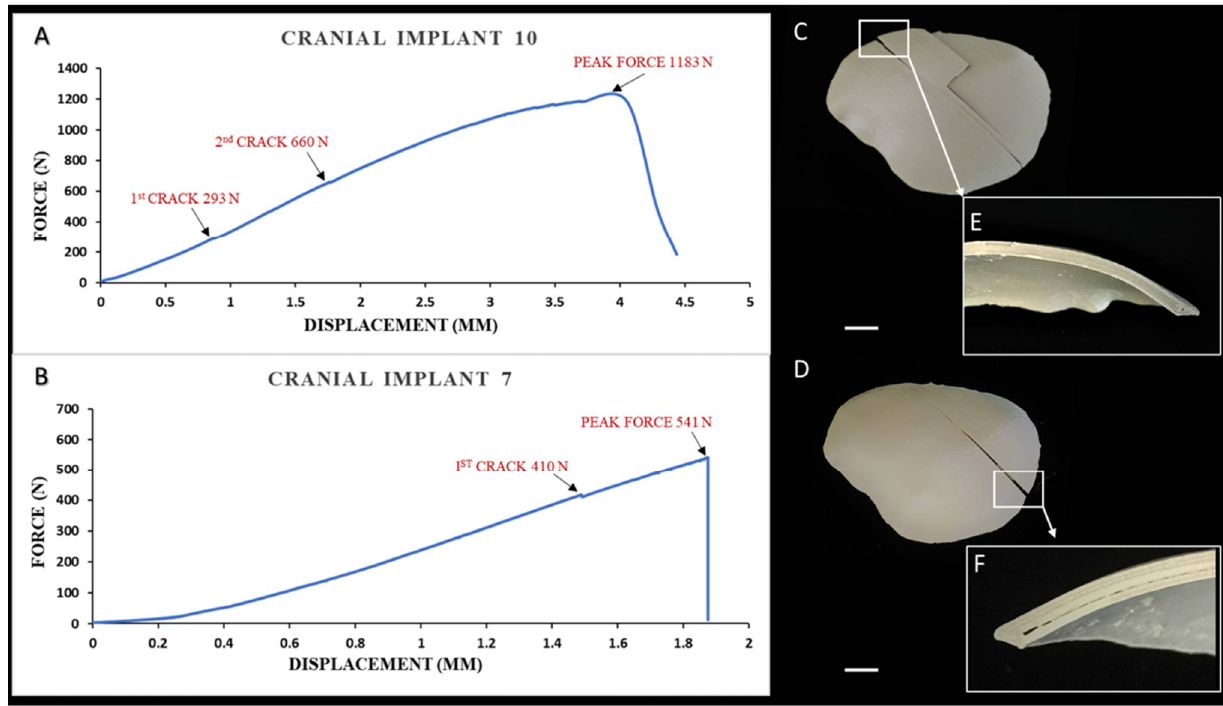
Figure 4. Biomechanical characteristics of the material extrusion 3D-printed PEEK patient-specific cranial implants: ( A ) Force–displacement curve response in an implant with the highest peak load; ( B ) Force–displacement curve response in an implant with the lowest peak load; ( C ) Multi-layered class 1 fracture pattern with intra- and interlayer connectivity (scale bar, 1 cm); ( D ) Linear class 3 fracture pattern confined to the intralayer interface (scale bar, 1 cm); ( E ) Magnified view of the white inset box displaying strong interlayer bonding in cranial implant 10; ( F ) Magnified view of the white inset box illustrating weak interlayer bonding with visible air gaps in cranial implant 7.